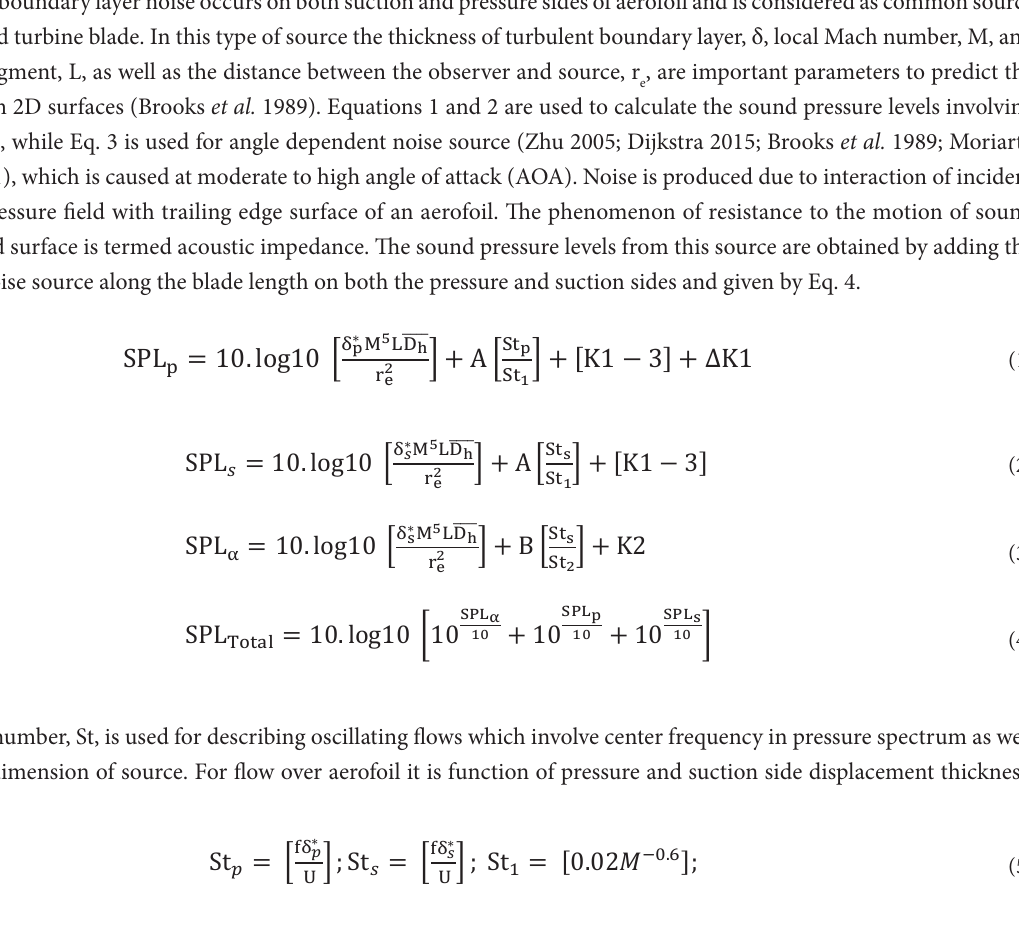
Turbulent boundary layer at trailing edge Trailing edge height